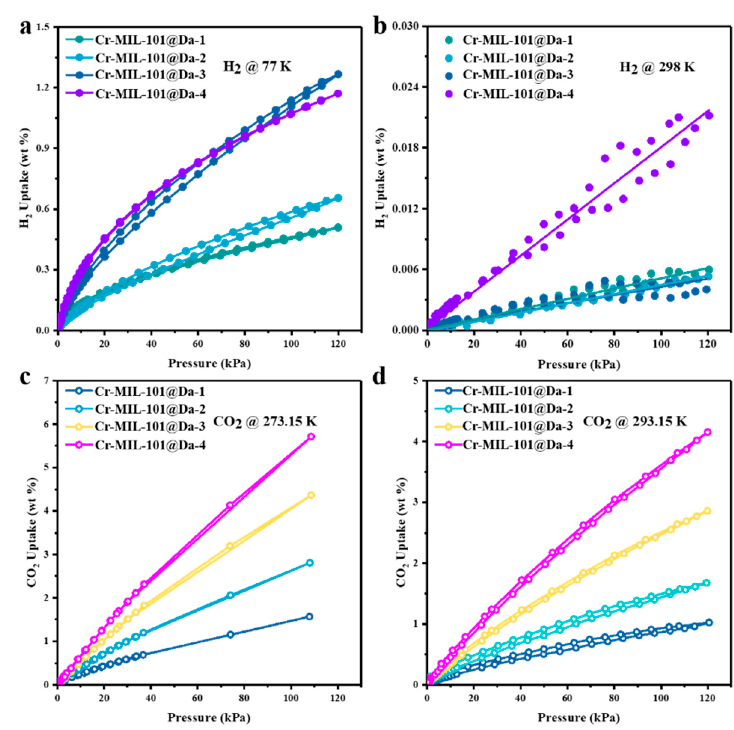
Figure 6. Gas adsorption performance of Cr-MIL-101@Da. ( a , b ) H 2 adsorption–desorption isotherm at liquid N 2 temperature and ambient temperatures and ( c , d ) CO 2 adsorption–desorption isotherm at 273.15 K and